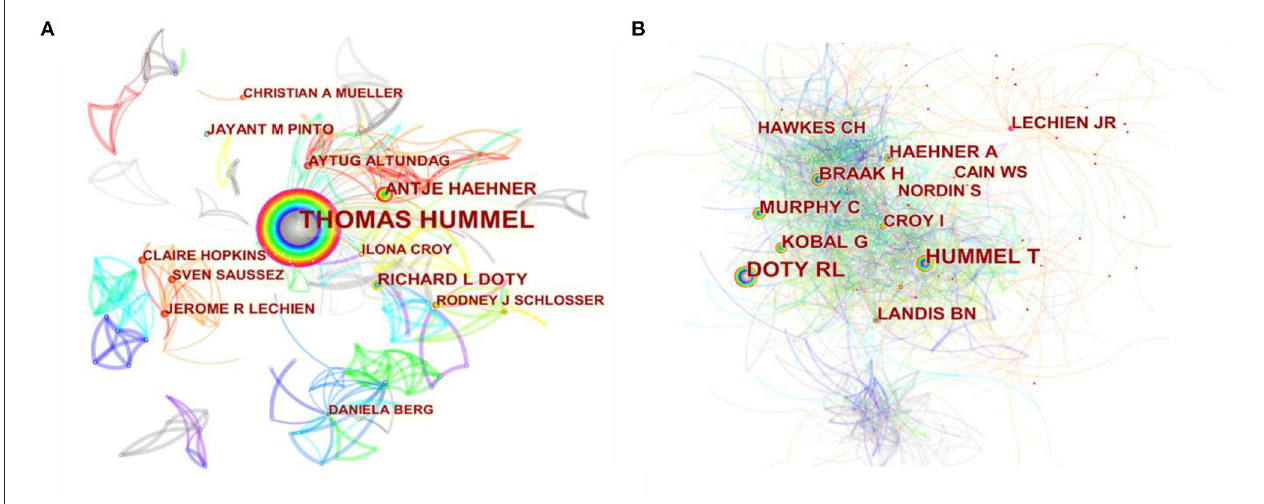
FIGURE 4 | A network map of authors (A) or co-cited authors (B) .